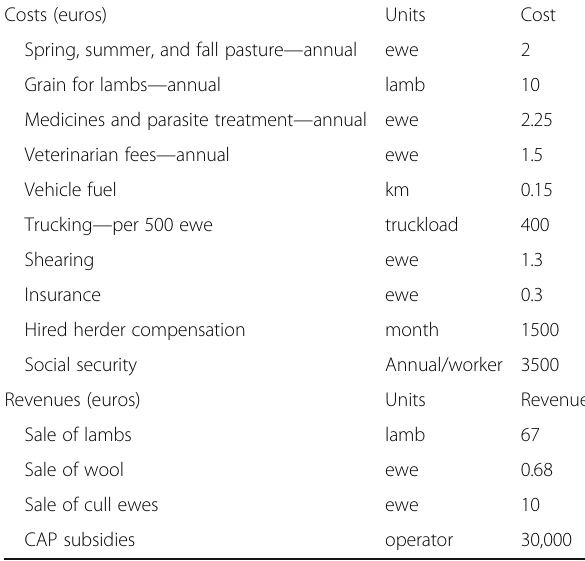
Table 2 Costs and revenues that are the same for semi- extensive and transhumant operations. At the time of